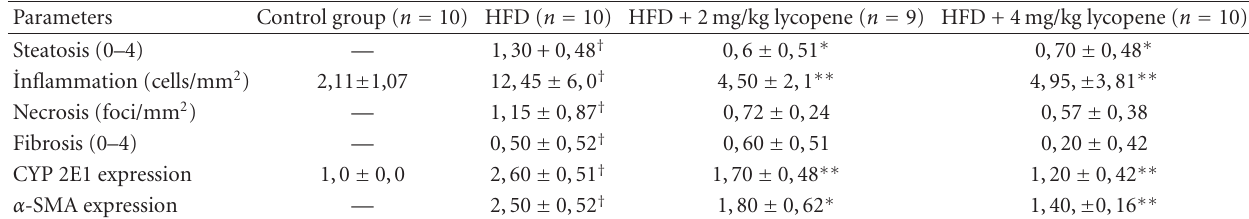
Table 4: The e ff ects of lycopene supplementation on histopathological changes.